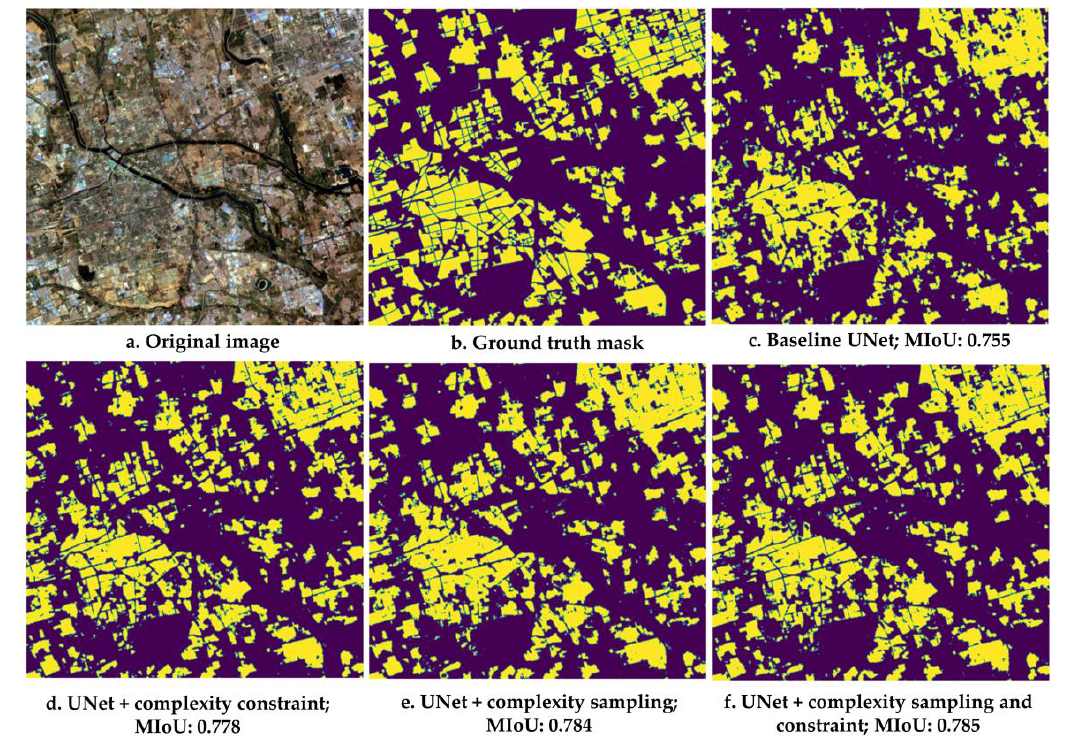
Figure 9. Comparison between build-up segmentation results of baseline UNet, UNets with complexity-informed constraint/sampling, and UNet with both. ( a ) shows the RGB images depicting true colors; ( b – f ) display yellow masks representing the build-up feature for ground truth ( b ) or predictions ( c – f ).